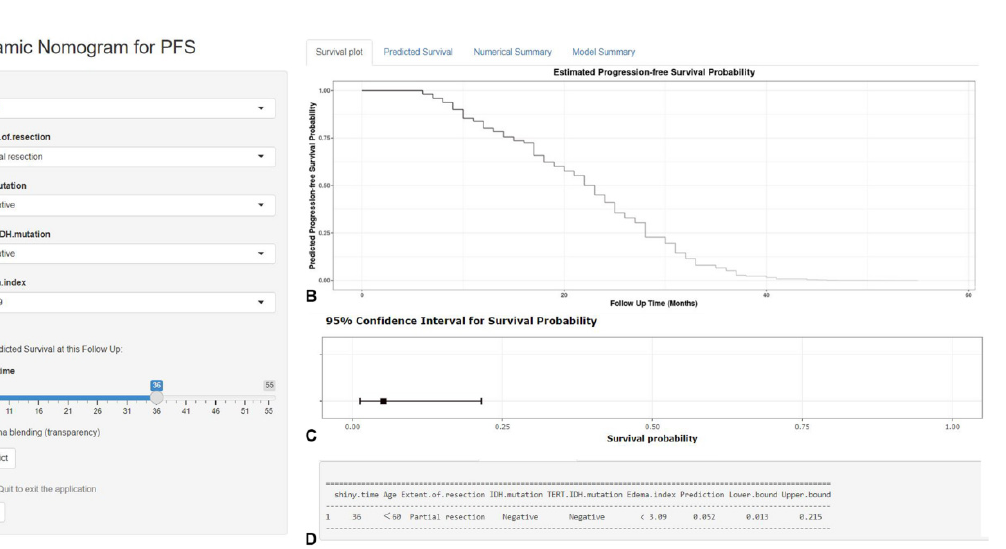
Figure 7. The screenshot of the online dynamic nomogram for PFS. After designating the items ( A ), neurosurgeons could easily plot the survival curve for an individual patient ( B ), predict the survival rate at each time point ( C ), and view the model summary ( D